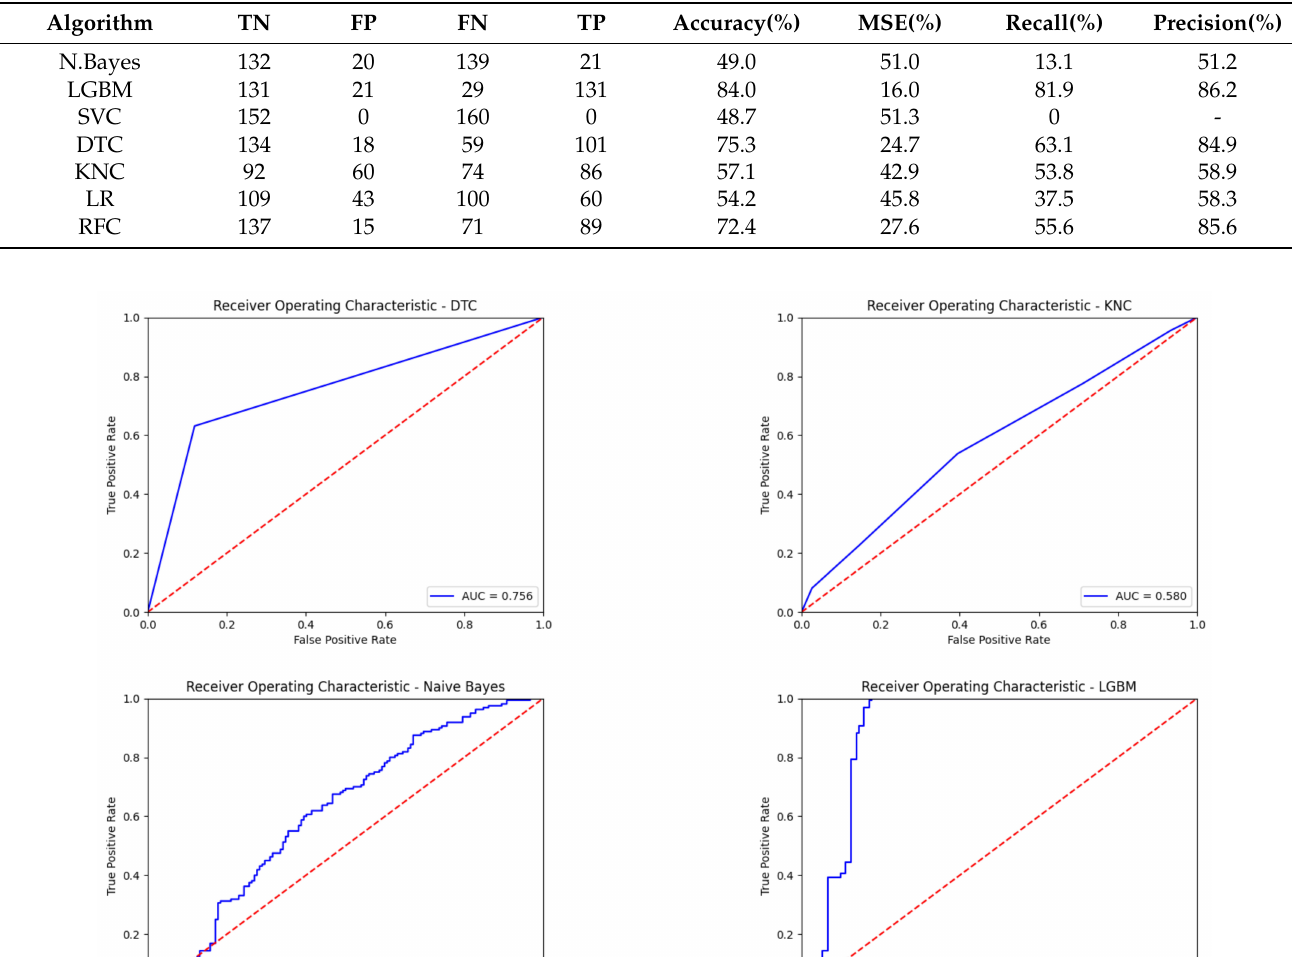
Table 6. The performance results using the first 13 channels of EEG signals with machine-learning classification algorithms.